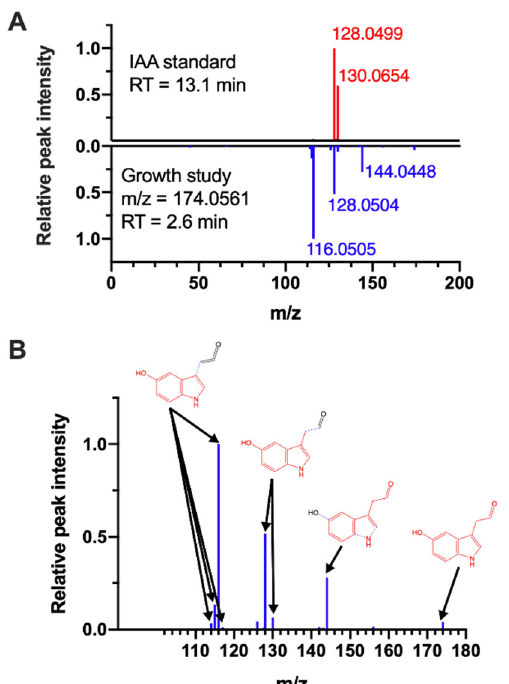
Figure 6. Annotation of 5-hydroxyindoleacetaldehyde (5-HIAAld). ( A ) Mirror plot of MS / MS spectrum for indole 3-acetate standard (top spectrum, red peaks) and the feature putatively identified as 5-HIAAld (bottom spectrum, blue peaks). The standard was run on the same instrument using the same LC–MS method as the sample. ( B ) Fragment structures of 5-HIAAld assigned by NIST MS Interpreter to the MS / MS spectrum shown in panel ( A ). Arrows point from fragments and ionization-related modifications (protonation, deprotonation, hydrogen transfer, and / or loss of water) to corresponding ion peaks. The fragments are highlighted in red. Dotted blue lines indicate covalent bonds that are broken to generate the fragment.